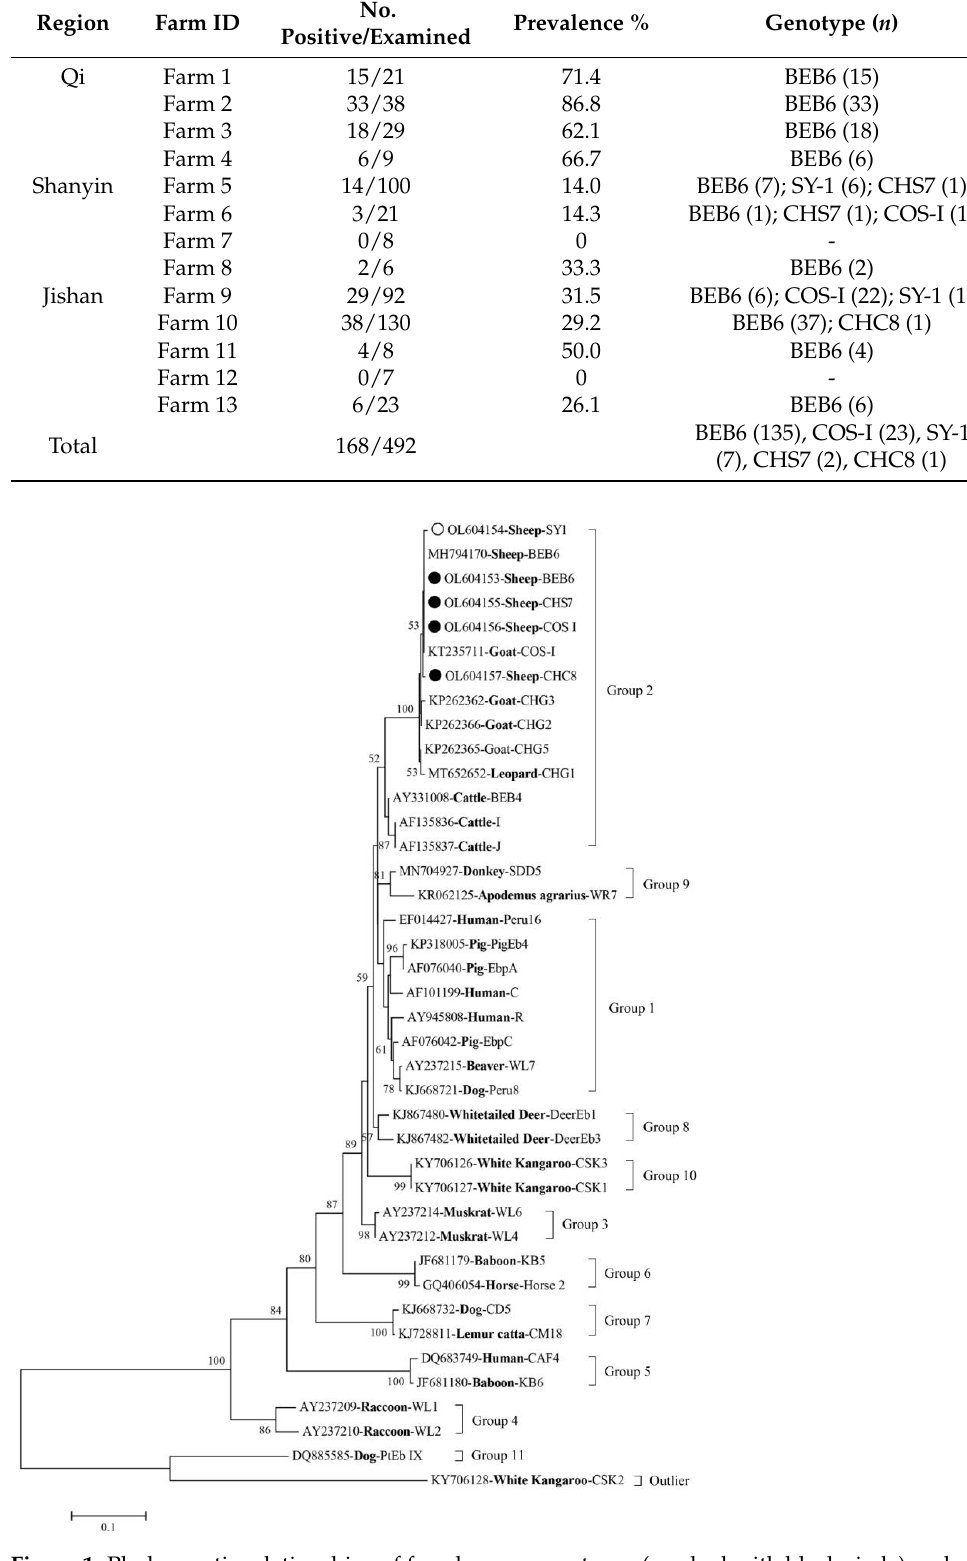
Figure 1. Phylogenetic relationships of four known genotypes (marked with black circle) and one novel genotype (marked with unfilled circle) of Enterocytozoon bieneusi , along with other genotypes identified in this study and previous reports. Bootstrap value higher than 50% is shown. Table 2 . Prevalence and genotypes of Enterocytozoon bieneusi in sheep in Shanxi Province.